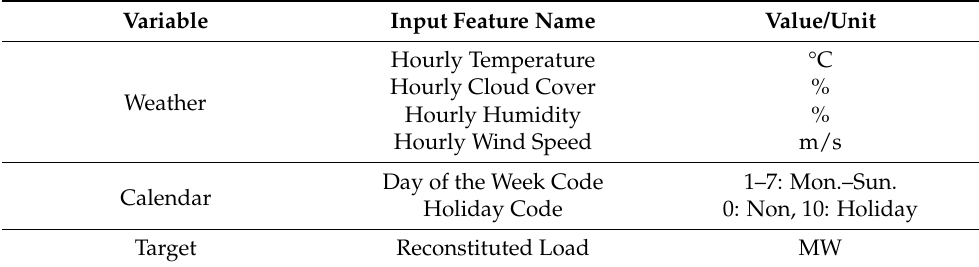
Table 1. The input variables used for load forecasting.